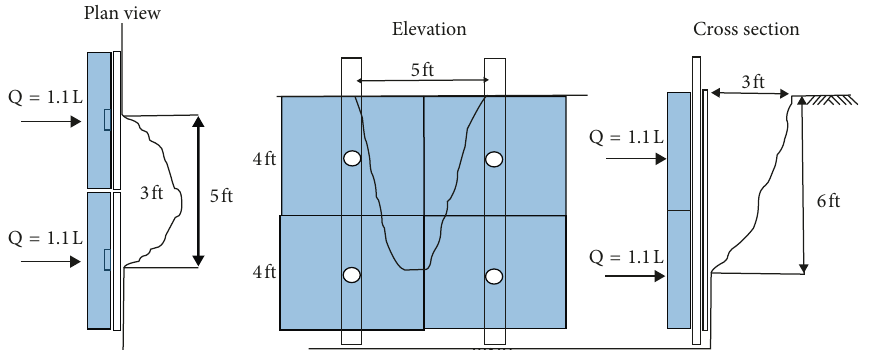
Figure 3: Scenario 1: failure geometry and emergency rescue shoring layout. Note that the panel placement shown is not ideal for actual rescue operations but demonstrates minimum necessary calculations.